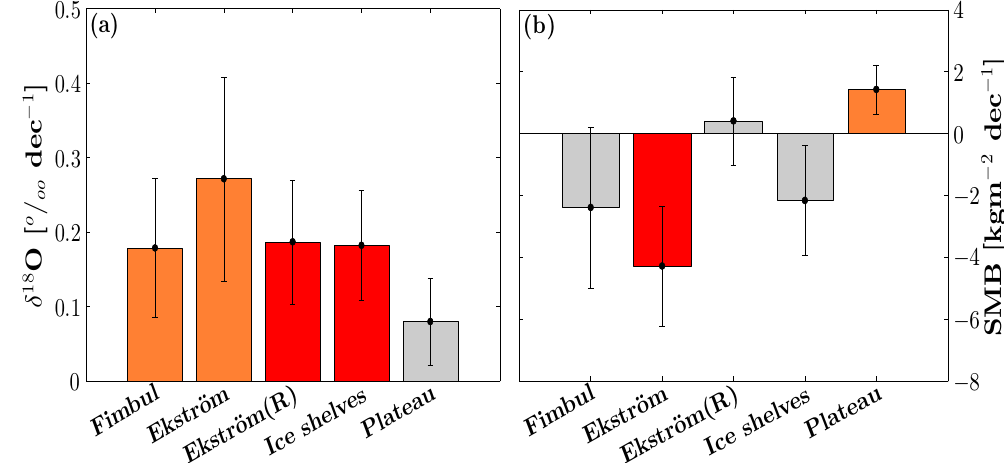
Figure 7. Linear trends for composite records of (a) δ 18 O and (b) SMB per decade between 1950–2000. Statistically significant trends on the 95% (90%) confidence level according to F test are shown as red (orange) bars. Trends with lower significance are coloured in grey. The black error bars represent the standard deviation of the slope.